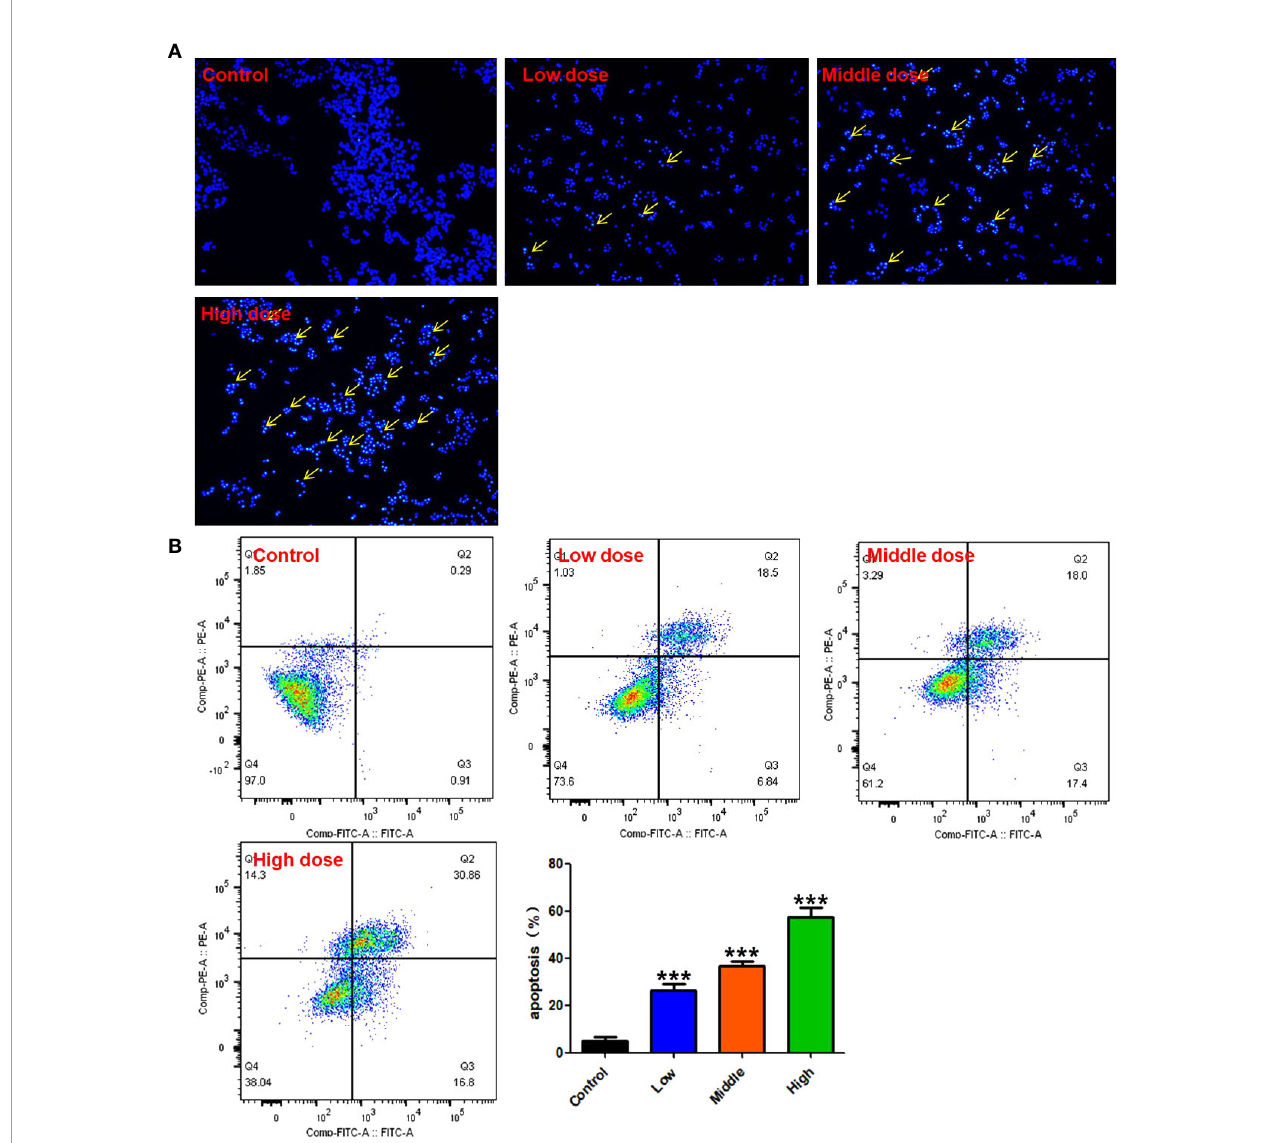
FIGURE 9 | Apoptotic induction acitivities of RPL on A549 cells. Cells were treated with RPL (0.2, 0.4, and 0.6 mg/mL) for 24 h, and the apoptotic effects of RPL were detected by (A) DAPI staining assay with a fl uorescence microscope and (B) fl ow cytometric analysis with Annexin V-FITC and PI staining. *** p < 0.001 vs.